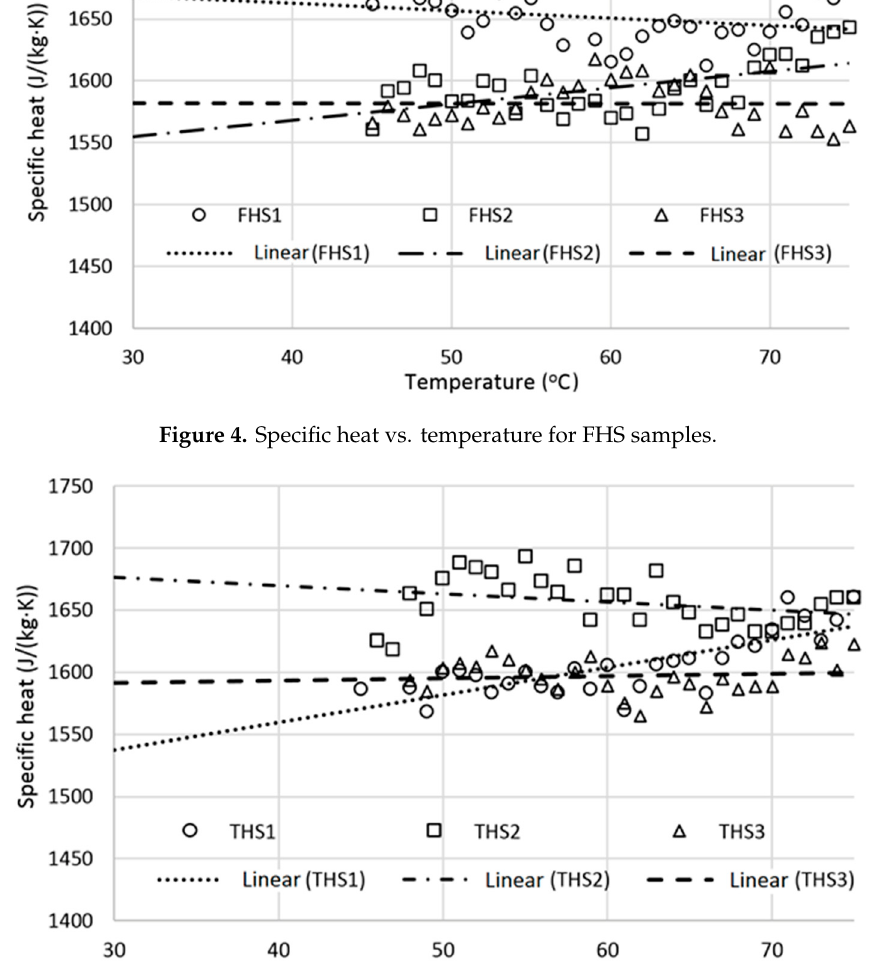
Table 6. Specific heat at T = 30 ° C.